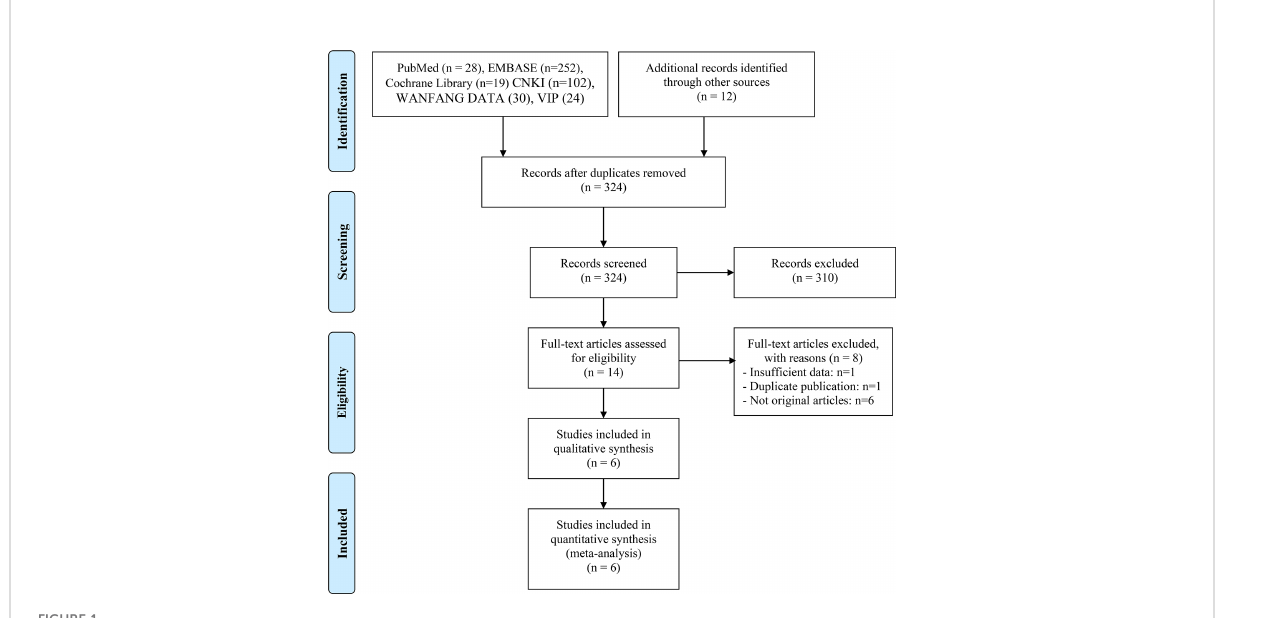
FIGURE 1 The fl ow diagram of identifying eligible